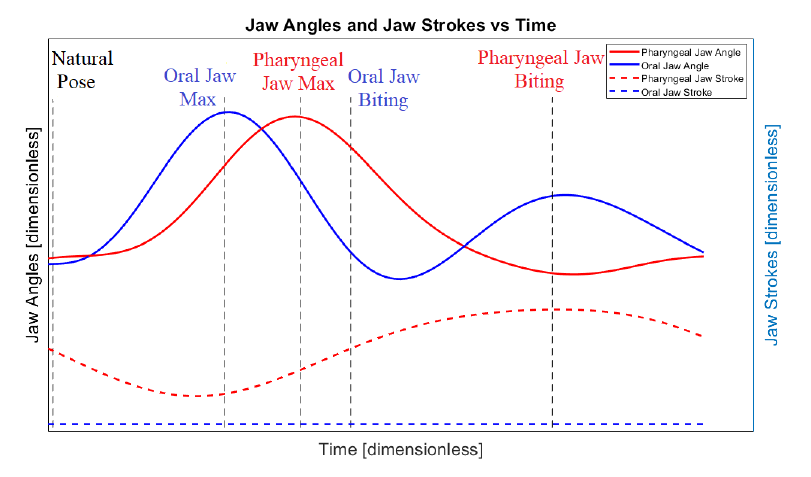
Figure 4. Approximation of the position and the angle requirements for both jaws.